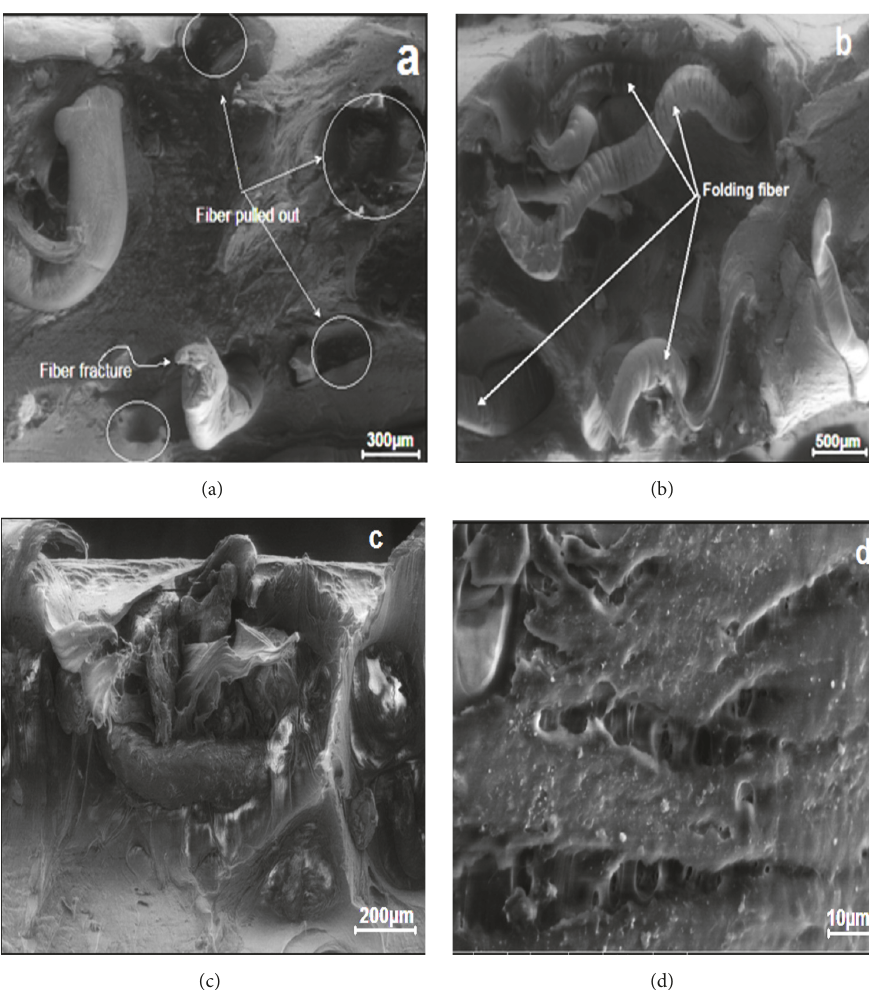
Figure 11: SEM micrographs of the tensile fractured surface of (a) 5 wt% PAfs/PP composite, (b) 5 wt% t-PAfs/PP composite, (c) 5 wt% t-PAfs/5wt% f-Na-MMT/PP hybrid composite, and (d) the tensile stretched surface of hybrid